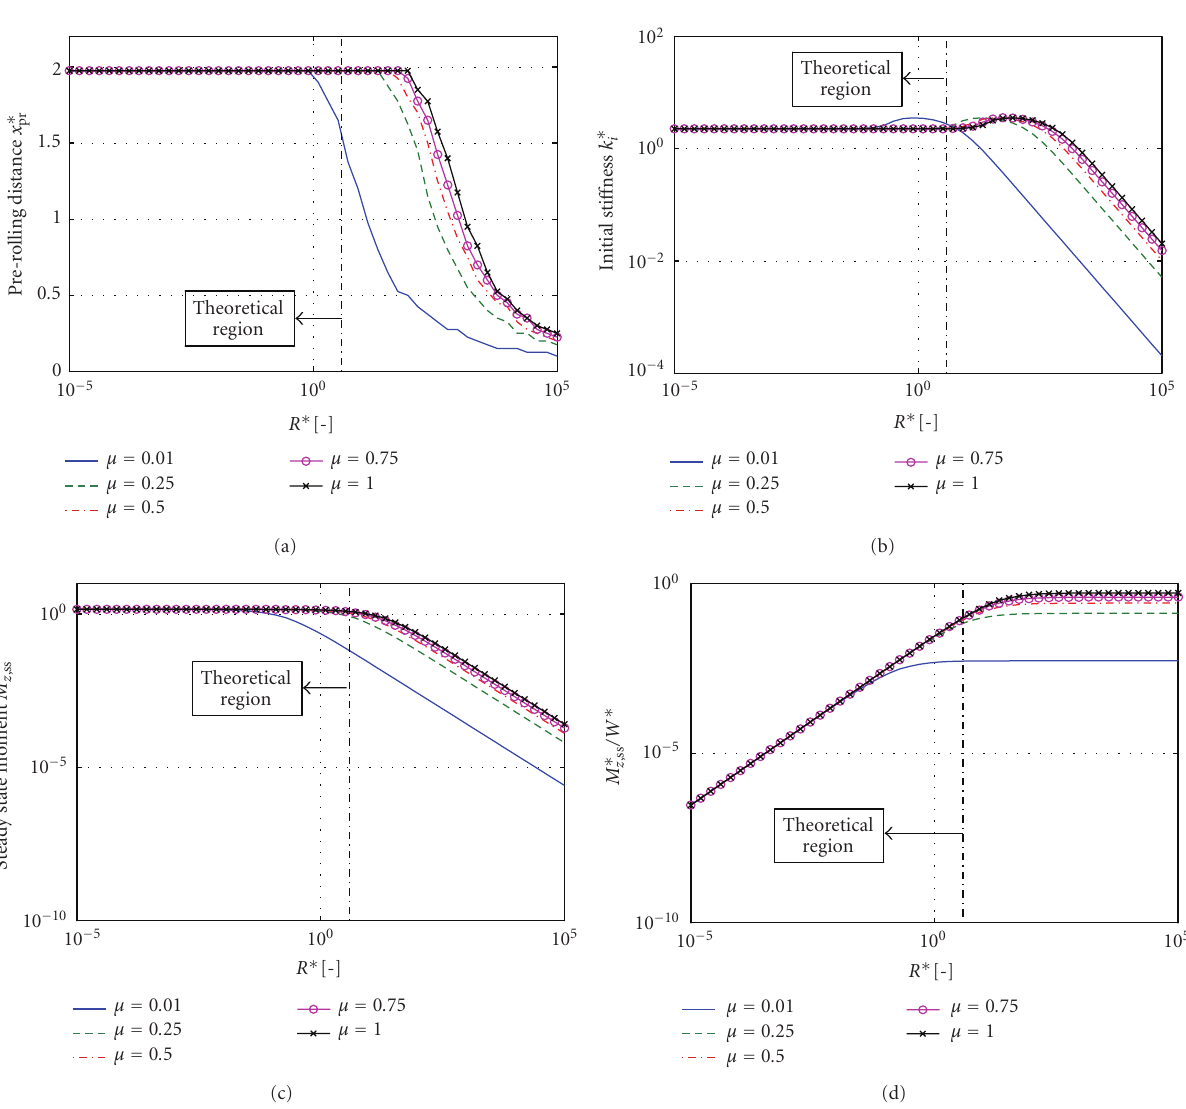
Figure 15: The behavior of the prerolling region on a variation of the ball radius for di ff erent coe ffi cients of friction μ ( φ = 0 . 05).